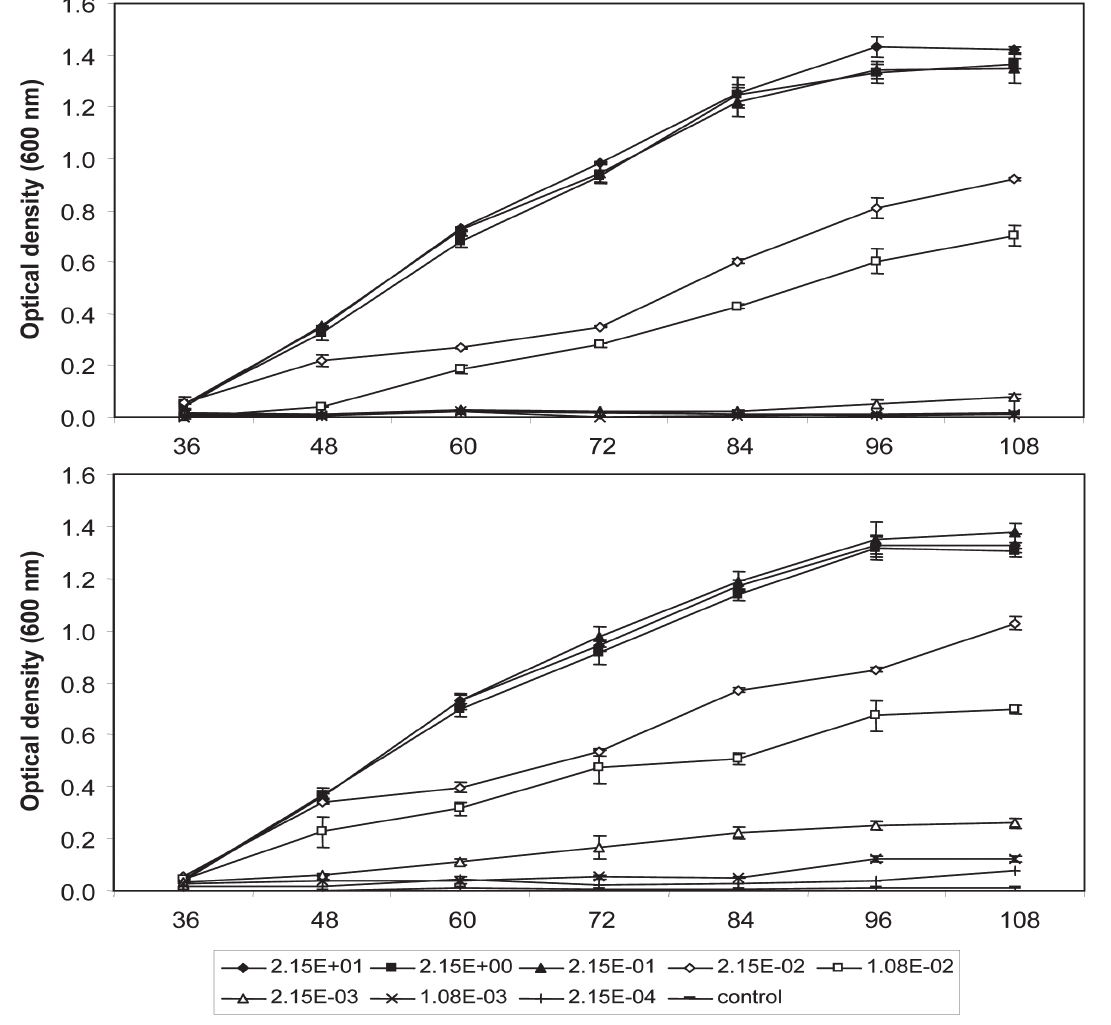
Figure 4. Growth of Erwinia amylovora in M9 minimal medium supplemented with 0.3 mM thiamine-hydrochloride and amended with varying amounts ( μ g mL -1 ) of nicotinic acid (A) and nicotinamide (B) at 48, 54, 72, 78, 96 and 108 h after inoculation. Each value is the average of 3 replications. Error bars represent the standard deviations of the means. The experiment was repeated once with similar